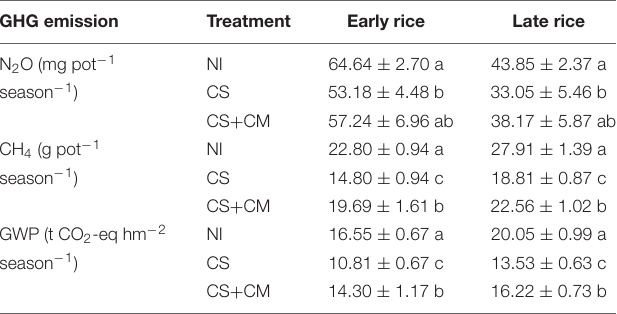
TABLE 2 | Seasonal cumulative emissions of N 2 O and CH 4 per pot and total seasonal GWP under different treatments in pot